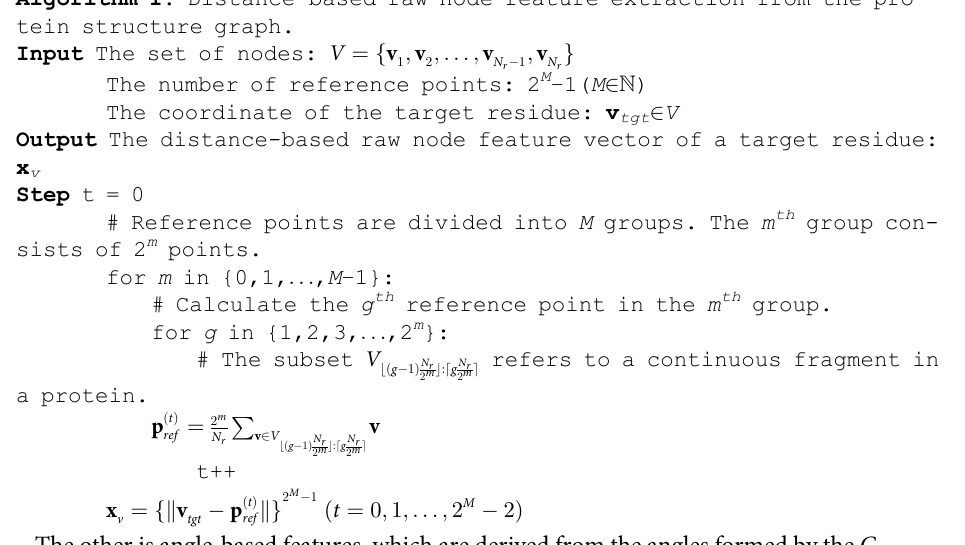
Algorithm 1. The length of the distance-based raw node feature vector x hyperparameter controlling the number of reference points. A proof that the distance-based feature is invariant to rotation and translation can be found in Text D of S1 File Algorithm 1 . Distance-based raw node feature extraction from the pro- tein structure